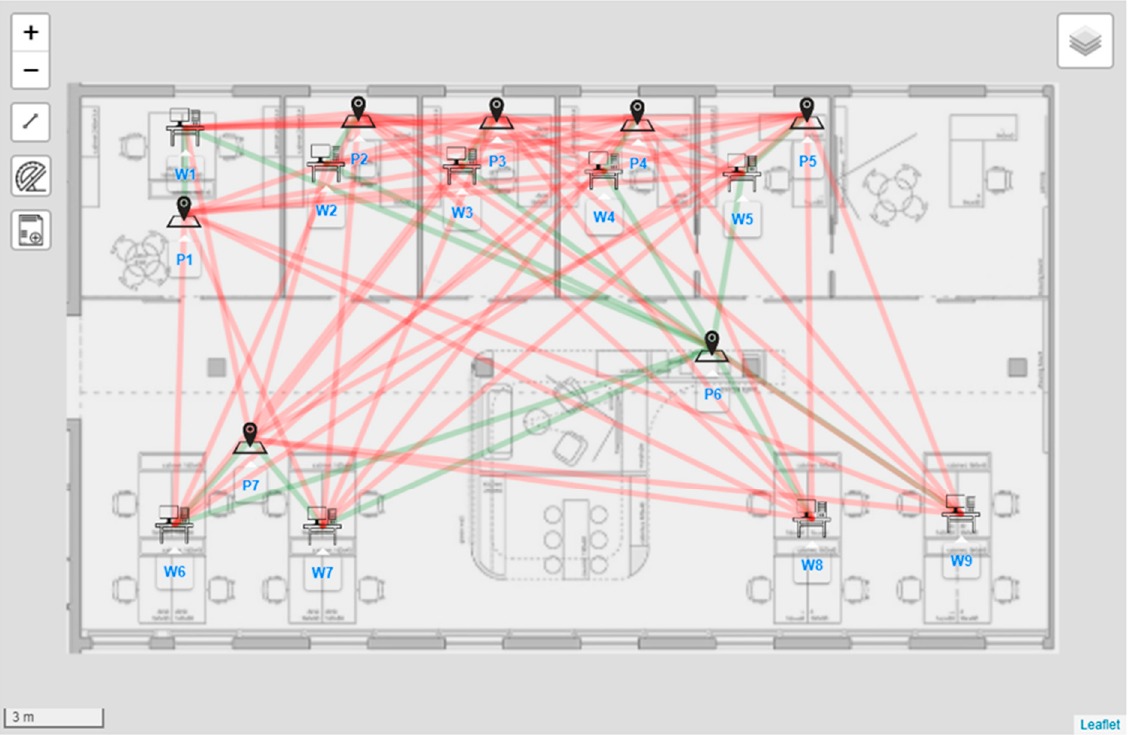
Figure 6. Case study floor plan ‐ local printer permissions for specific workstations (W1–W9) and printers installed at candidate locations (P1–P7).